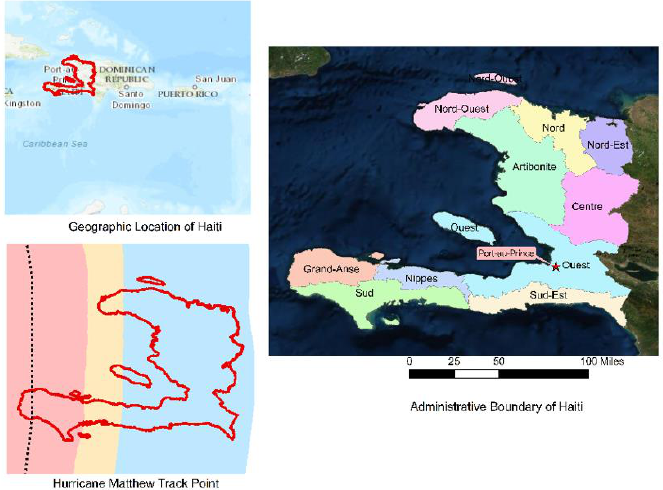
Figure 1. Administrative area of Haiti and Hurricane Matthew Track